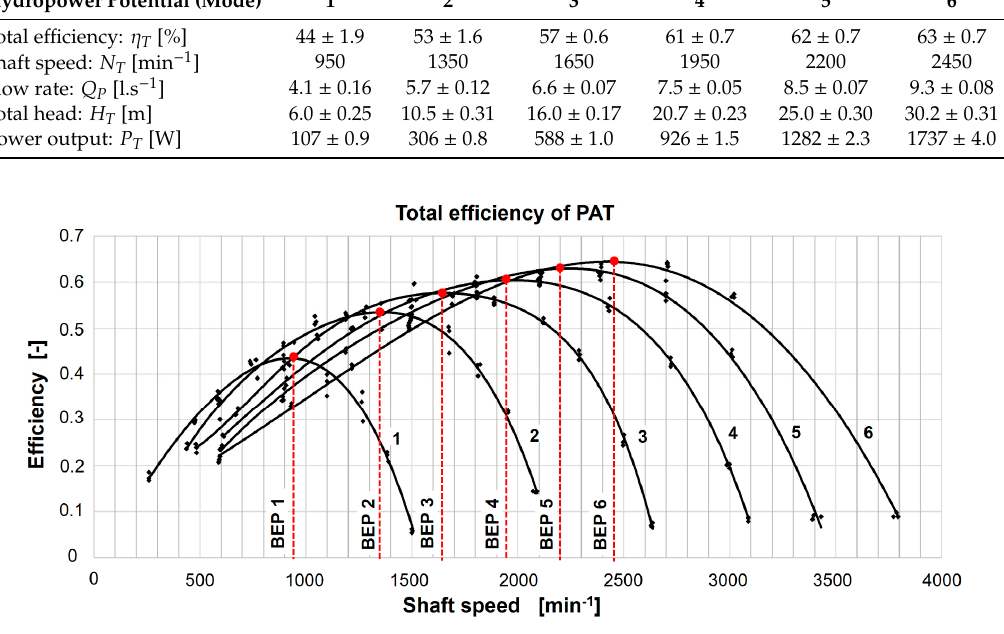
Figure 5. Courses of efficiency in modes 1–6 highlighting the optimum best efficiency point (BEP). Energies 2019 , 12 , x FOR PEER REVIEW